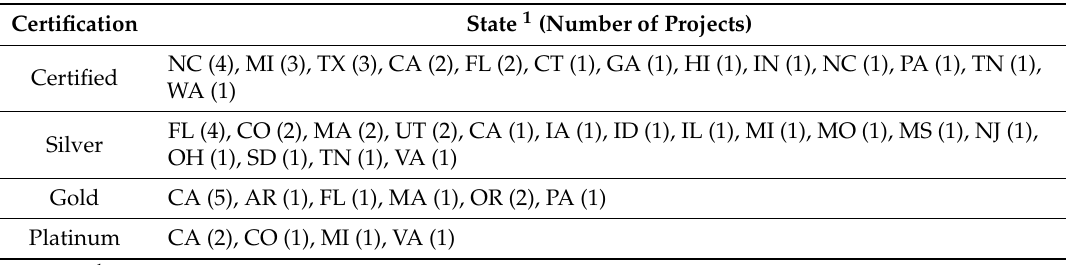
Table 1. Distribution of Leadership in Energy and Environmental Design (LEED)-NCv4 Certified, Silver, Gold, and Platinum projects in the U.S. in